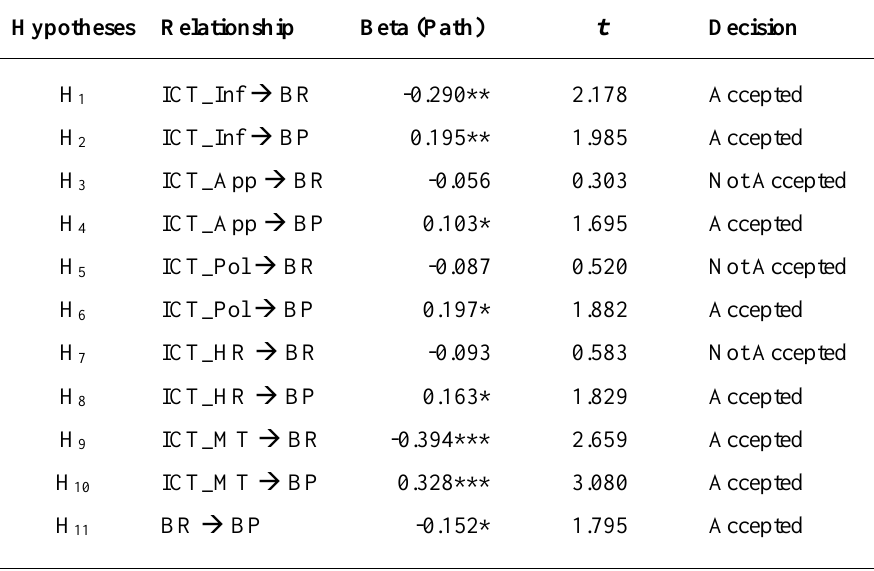
Table 6: Path Coefficient and Significance